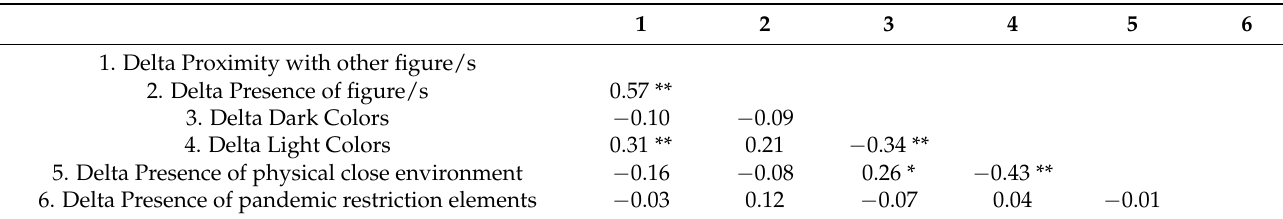
Table 6. Correlations between all